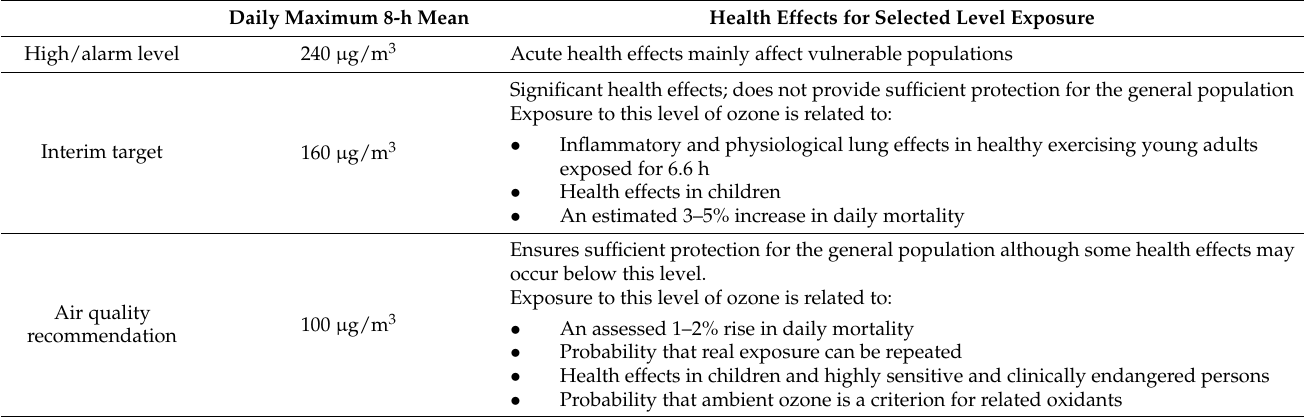
Table 1. WHO air quality guidelines for ozone (8-h concentrations) based on time-series research